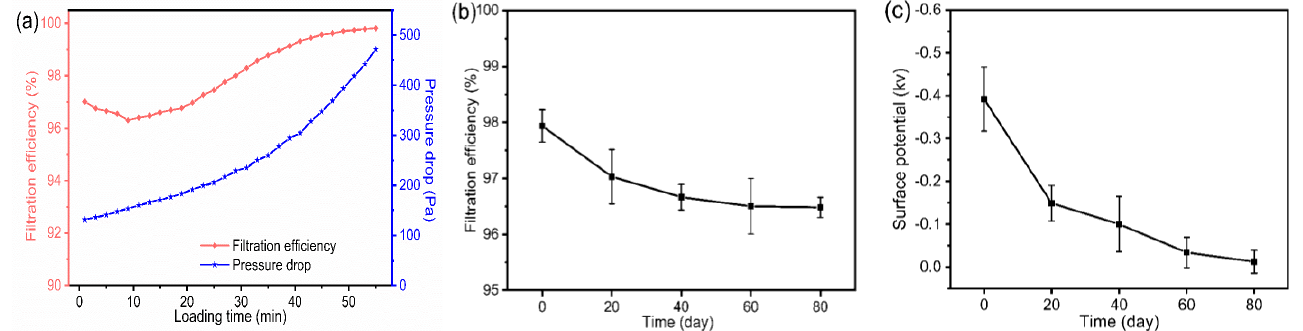
Figure 8. ( a ) Filtration efficiency and pressure drop during loading. Decaying test of M 3 E 3 *5 within 80 days, ( b ) Filtration efficiency decay, ( c ) Surface potential decay. The detection particle size is 0.3 µm in ( a , b ).